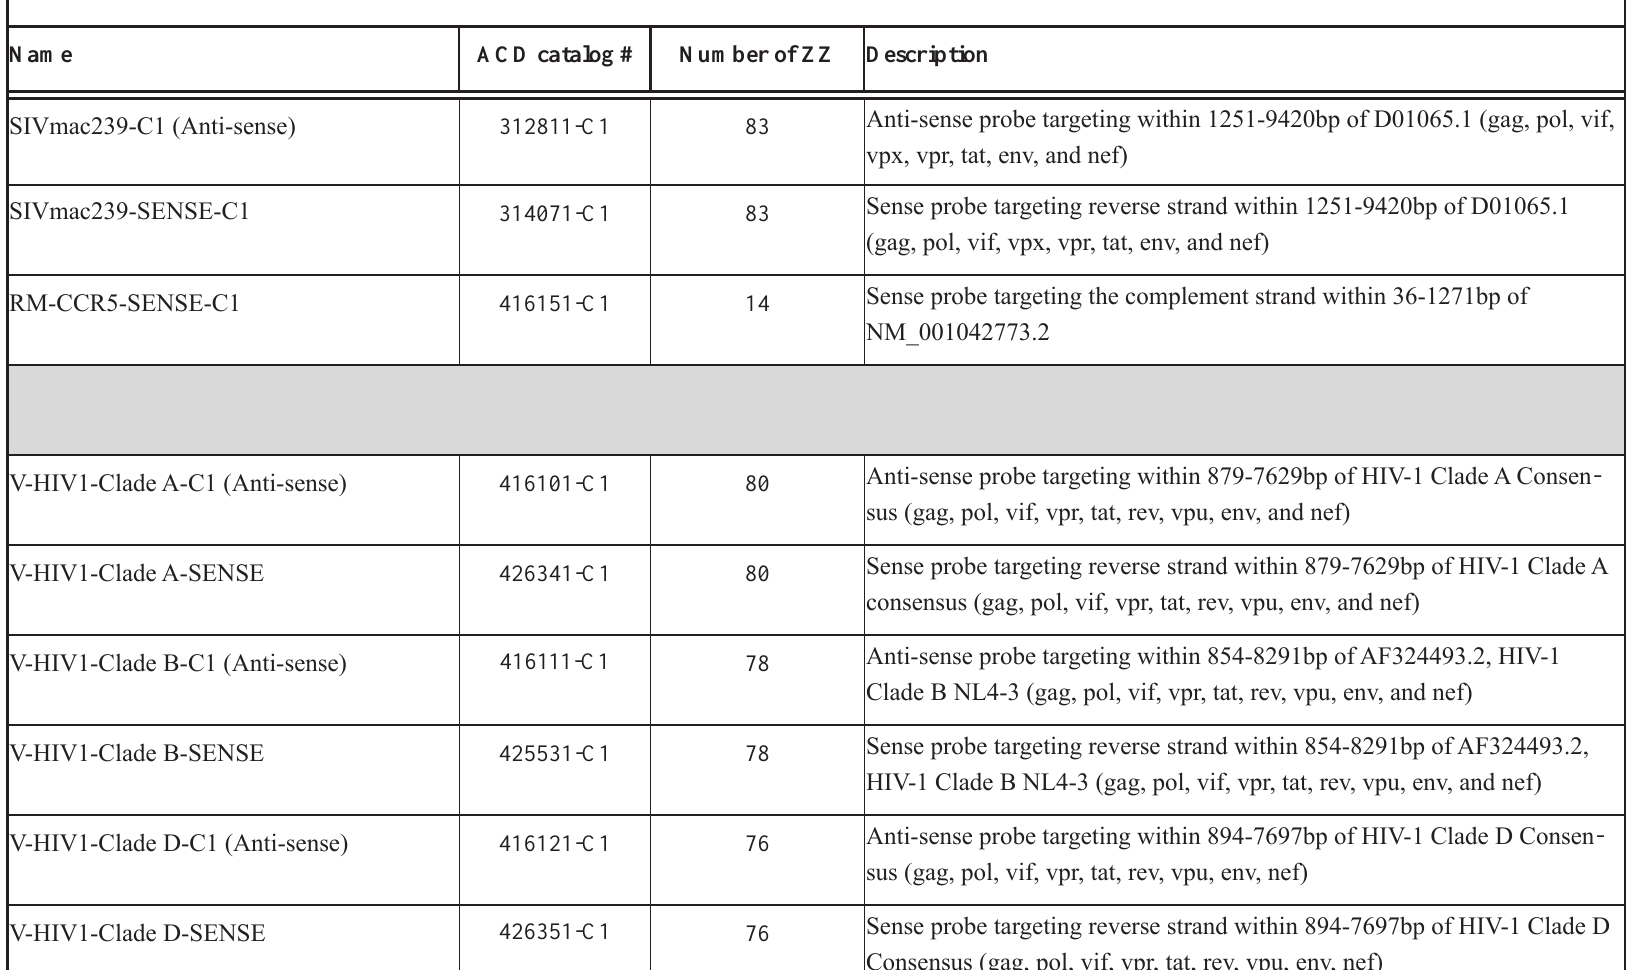
Supplemental Table 2 . Single-plex RNAscope and DNAscope probes Single-Plex RNA/DNAscope Probe